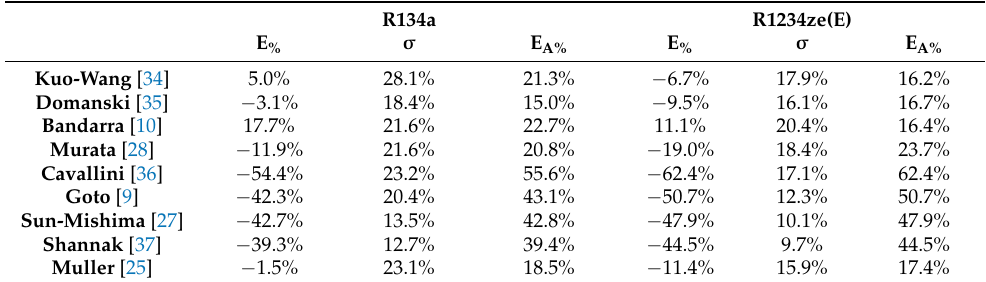
Table 5. Comparison between the experimental data concerning the pressure drop per unit length and the predictions provided by some of the correlations available in the open literature.